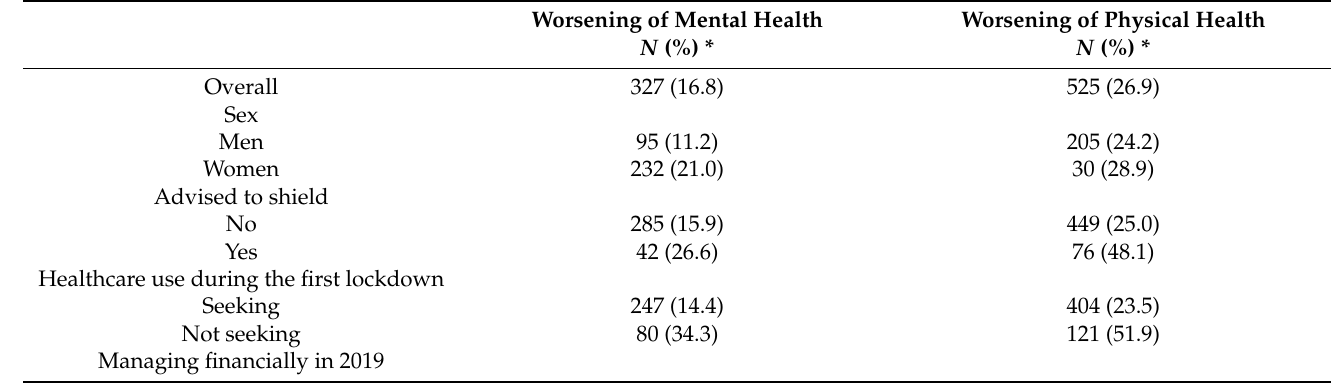
Table 2. Characteristics of participants with mental or physical health worsening since the beginning of